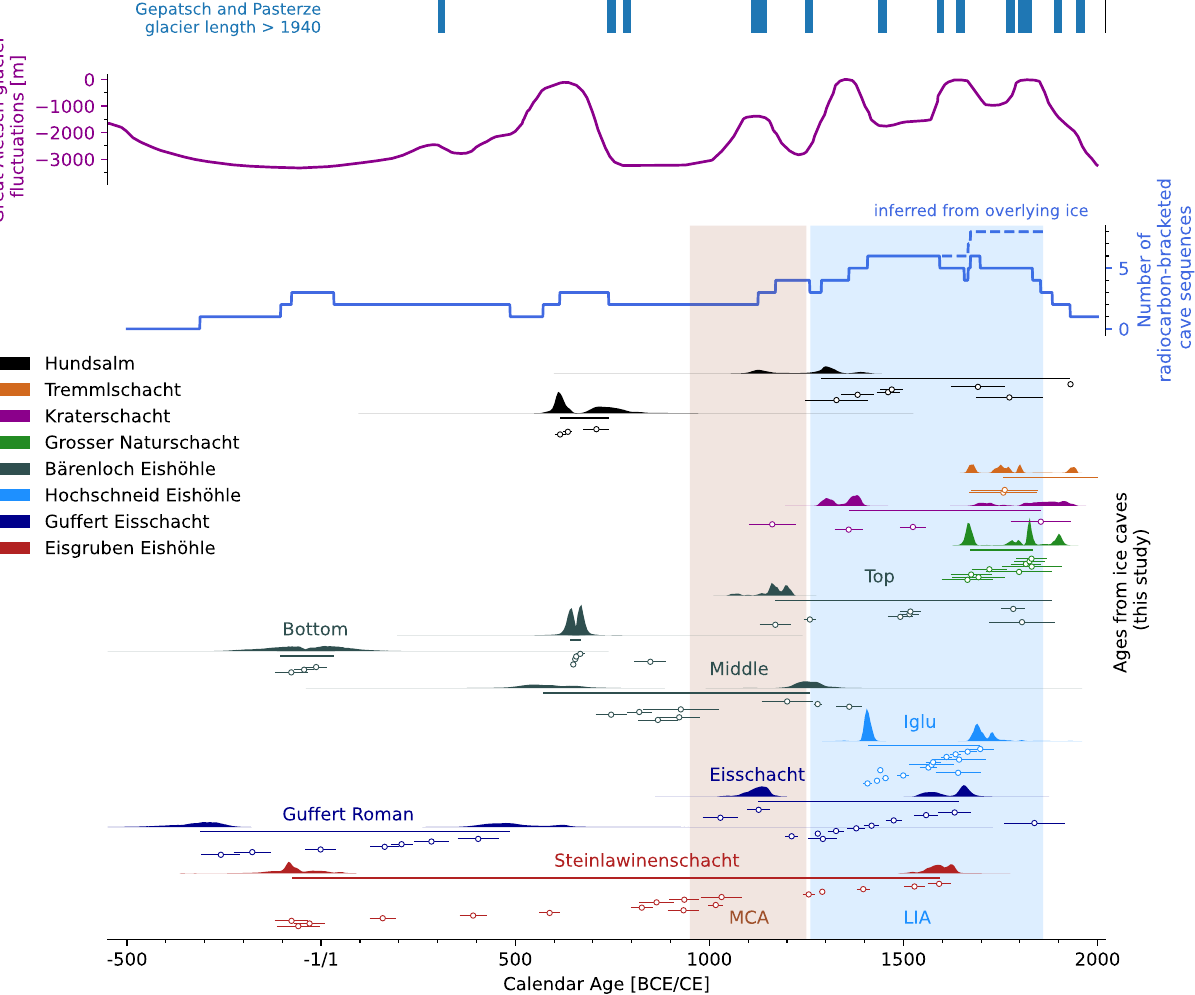
Figure 4. Graphical summary of radiocarbon dates of eight alpine ice caves, plotted alongside past glacier length changes of ( a ) the Lower Grindelwald Glacier 55 , ( b ) the Great Aletsch glacier 43 , ( c ) a number of replicated positive MAMB phases; a count of one was attributed whenever two dated sections from a single cave overlapped, e.g., Eisgruben from 0 to 500 CE, ( d ) summary of the radiocarbon dates; open circles denote median modelled ages, single continuous lines represent the duration of the sections, while areas filled with a solid colour denote the posterior probability density of the starting and ending boundaries. Note that from 1700 to 1850 CE, the number of radiocarbon-bracketed sequences ranges between five and six. This is because the dated sections of Eisgruben, Hochschneid and Guffert end when those of Großer Naturschacht and Tremml- Schacht-413 start. However, given that a large volume of ice was deposited on top of the radiocarbon-dated sequences, we postulate that Hochschneid, Guffert and Eisgruben also experienced positive mass balance for some decades after their youngest radiocarbon samples, bringing the actual total number of cave sequences with positive MAMB to a full eight for the period 1750 CE to 1850